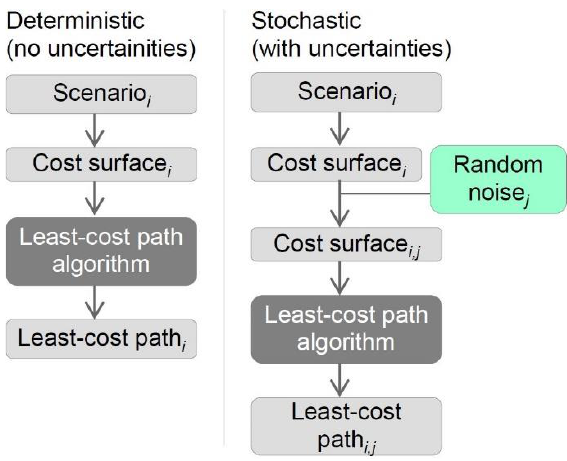
Figure 2. Workflow for deterministic and stochastic LCP models. Subindex i implies a different scenario. Subindex j identifies a specific random noise.